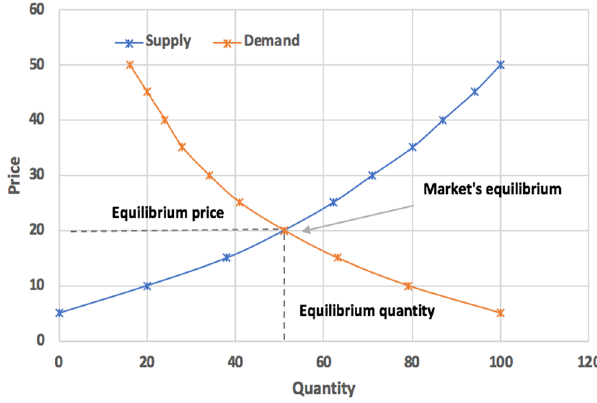
Figure 2. Equilibrium of supply and demand.